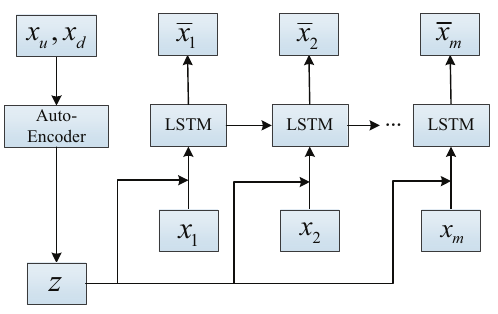
Figure 3. The structure of AE-LSTM for traffic flow prediction. AutoEncoder model is used to extract features and LSTM model is used to predict the traffic